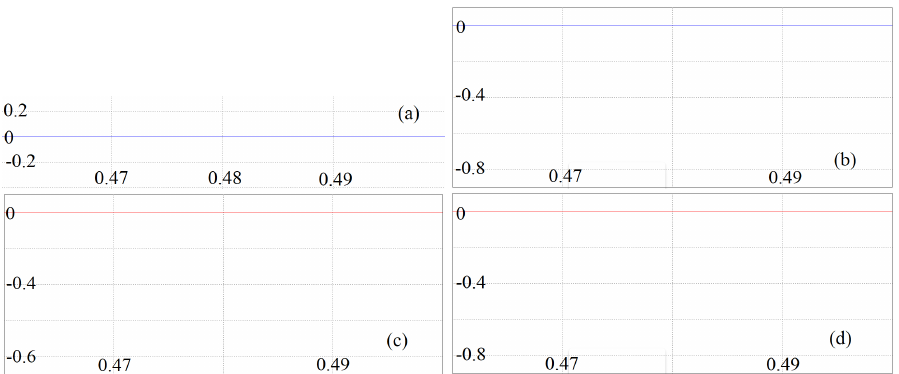
Figure 18. Time-series waveforms of the four state-variables obtained from the circuit simulation for ω nd = 3.89. For each figure, x -axis is the time in sec and the y -axis is the values of y 1 , y 2 , z 1 , and z 2 , respectively in V. ( a ) Time-series waveform of z 1 , ( b ) Time-series waveform of y 2 , ( c ) Time-series waveform of y 1 , and ( d ) Time-series waveform of z 2 . The frequency of the sine wave generator is 12.382 kHz. The initial condition has been chosen at (0.333,0,0,0) to obtain the time-series waveforms. (Color Online).